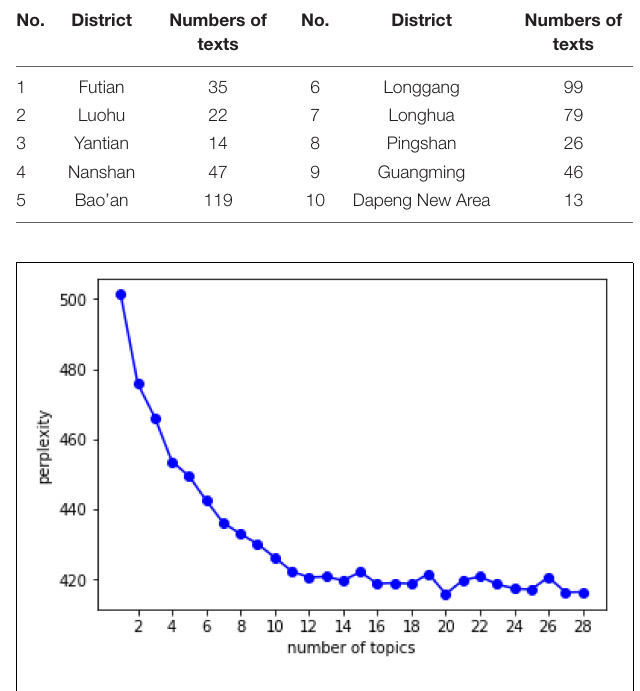
FIGURE 2 | Topic confusion value diagram.